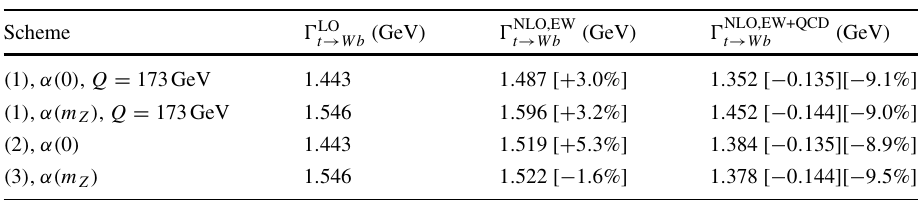
Table 2 Partial decay width H → b ¯ b for different values of Q , see text for